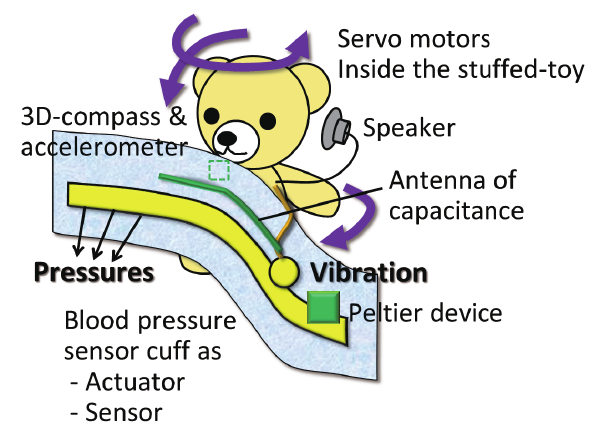
Figure 2: System con(cid:28)guration of wearable message robot for detecting the activity of both the user and robot and a speaker are placed inside the robot. A vibration motor for the haptic stimuli is attached to the (cid:28)xing textile. An antenna of capacitance (as used in theremins) is placed on the lower part of the (cid:28)xing strap to measure the thickness of the user’s clothes to accordingly adjust the strength of the haptic